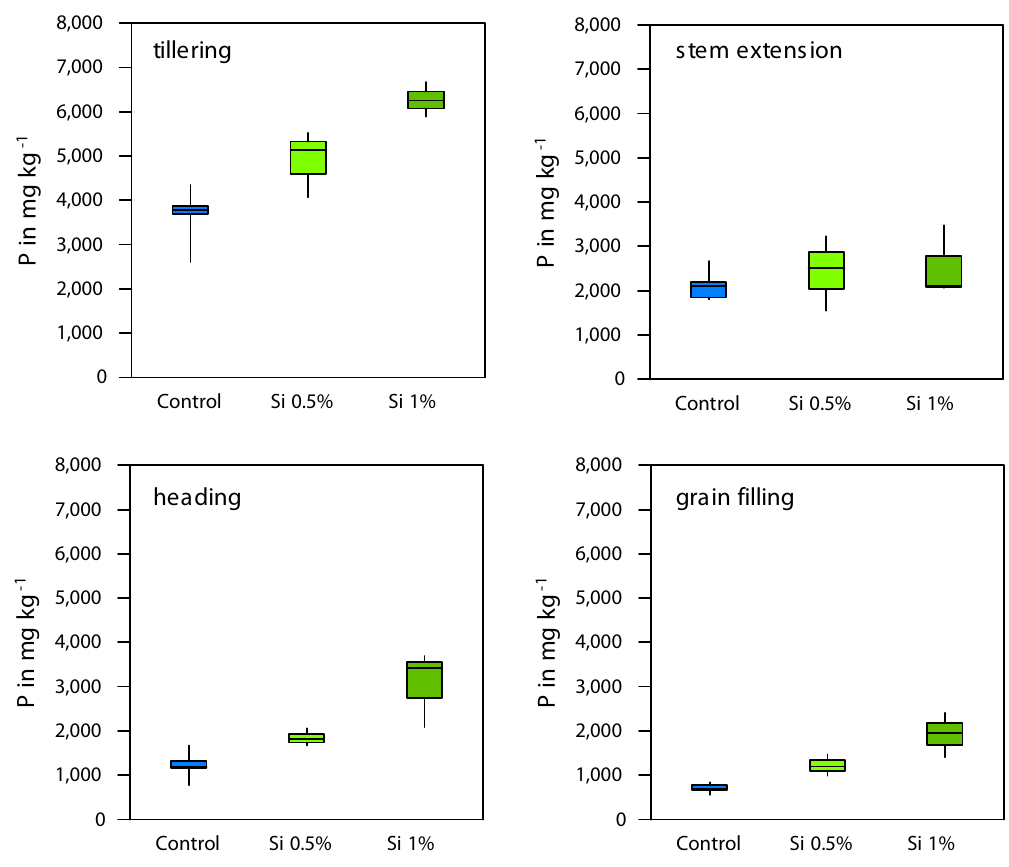
Figure 8. Leaf phosphorus concentration for the different treatments over the growing